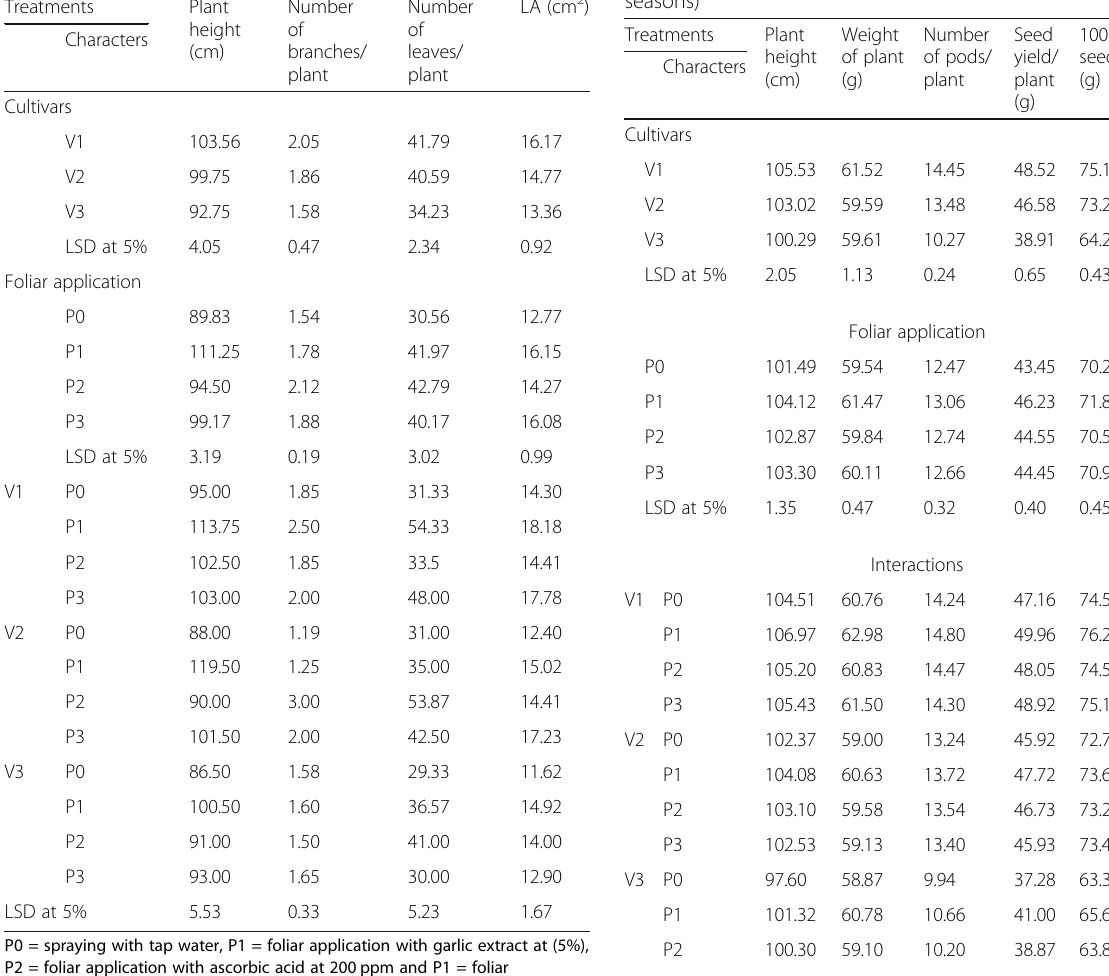
Table 3 Effect of cultivars, foliar application of garlic extract, ascorbic acid or nicotinamide and interactions on yield and its components of faba bean plants (data are means of